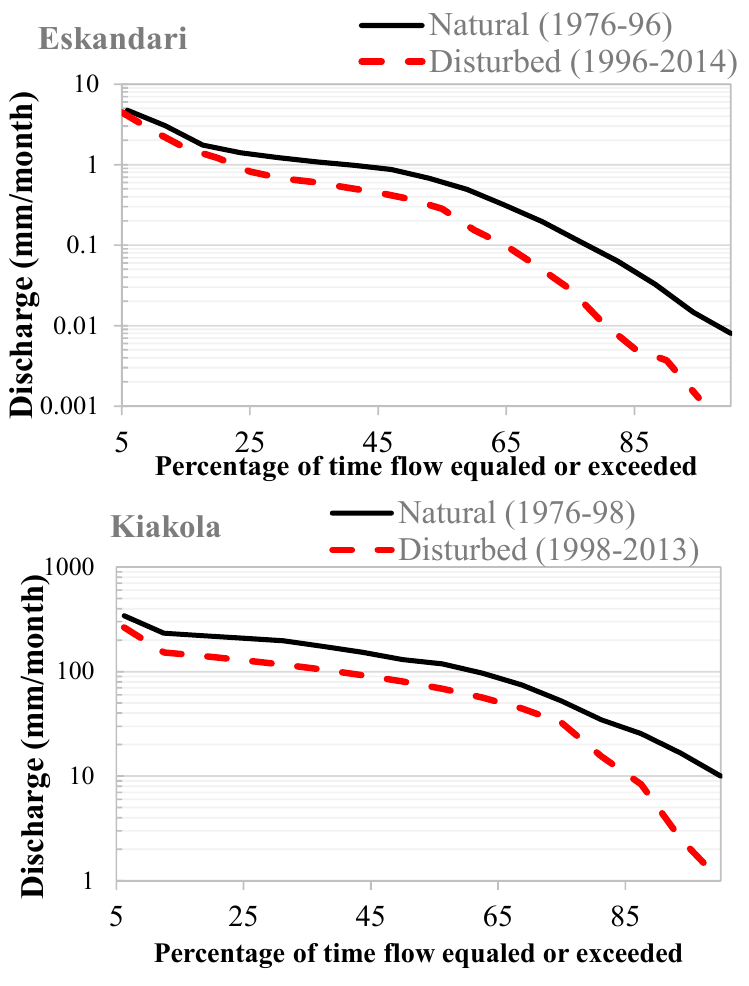
Figure 6. Flow duration curves of monthly discharge for natural and disturbed conditions.